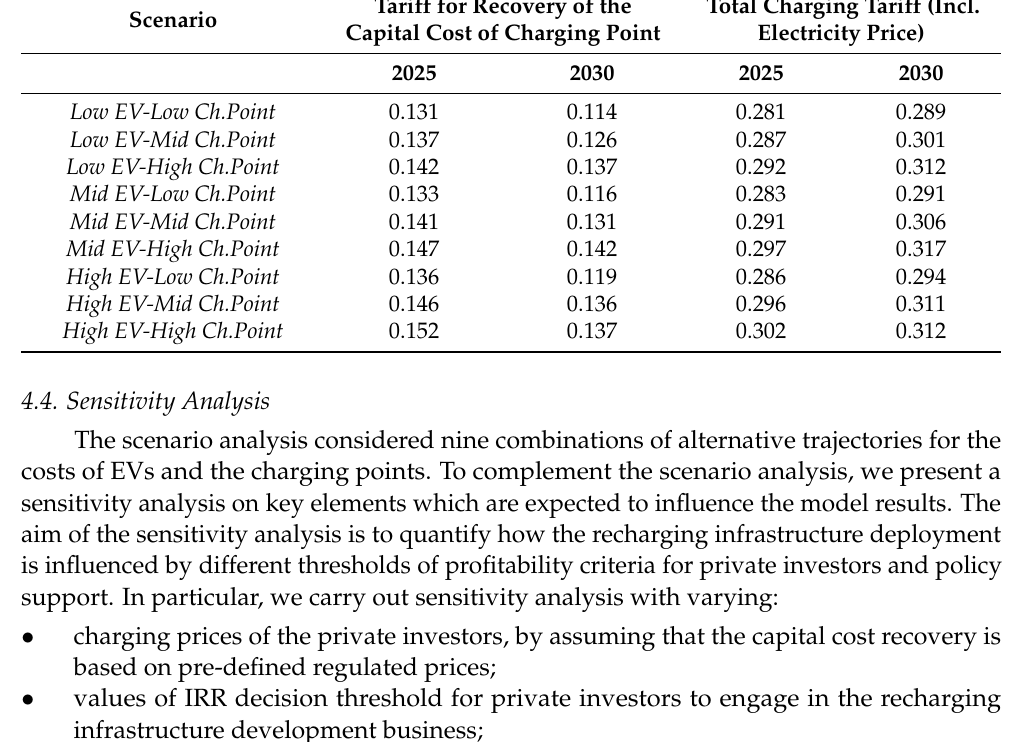
Table 12. Charging price in euro/kWh in 2025 and 2030. Tariff for Recovery of the Scenario Capital Cost of Charging Point 2025 2030 2025 2030